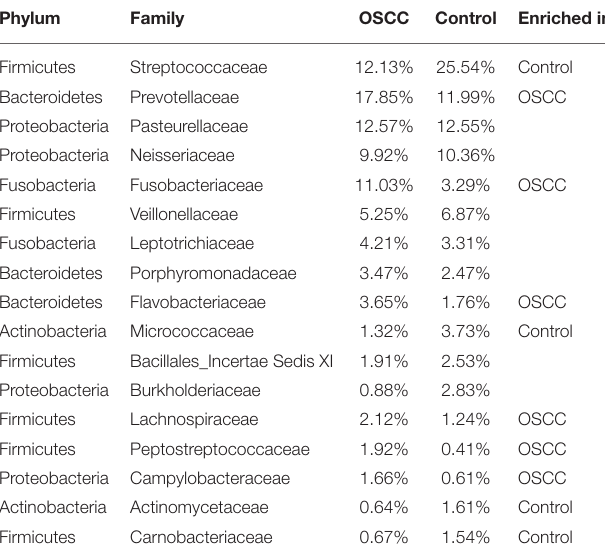
TABLE 2 | Dominant families and significant differences between the OSCC and Control groups computed by STAMP.